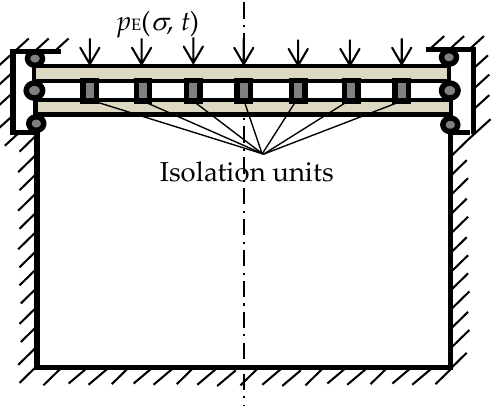
Figure 1. Schematic of the sound insulation system with double-layer plate structure and active actuators for the water-filled acoustic cavity.